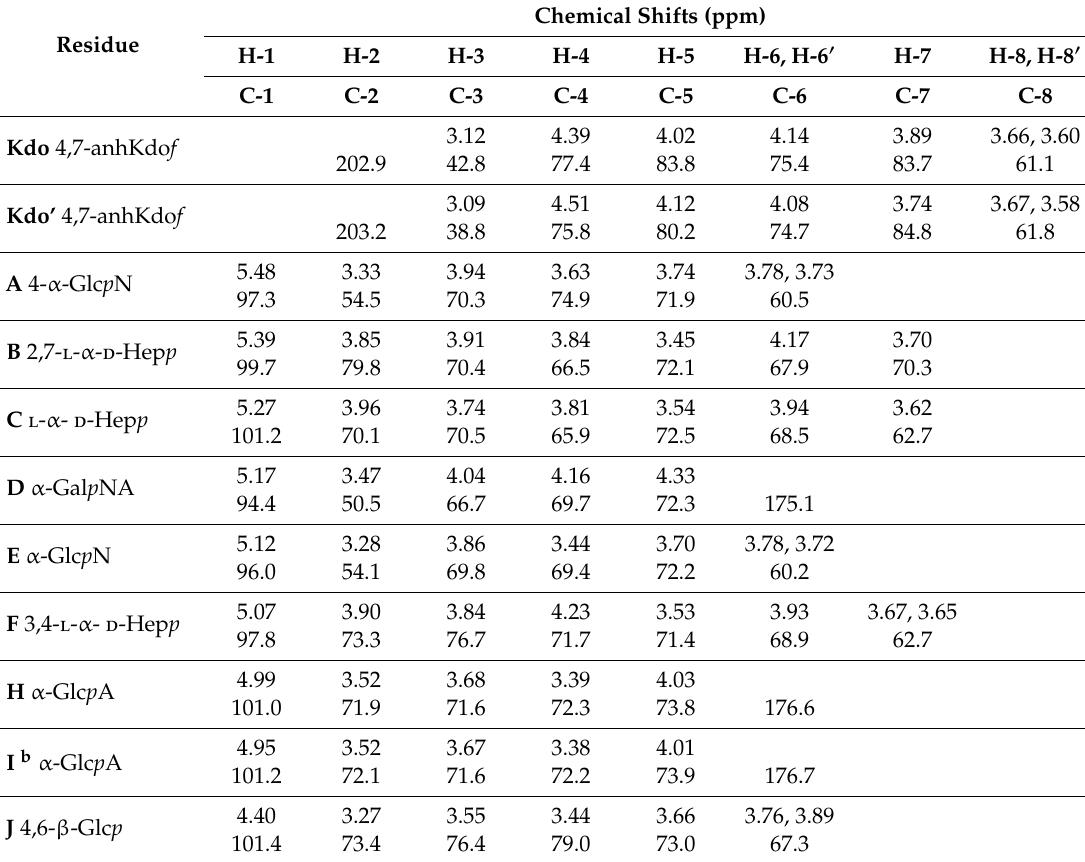
Table 3. 1 H and 13 C NMR chemical shifts of the B. holmesii ATCC 51541 core oligosaccharide a . Chemical Shifts (ppm) Residue H-1 H-2